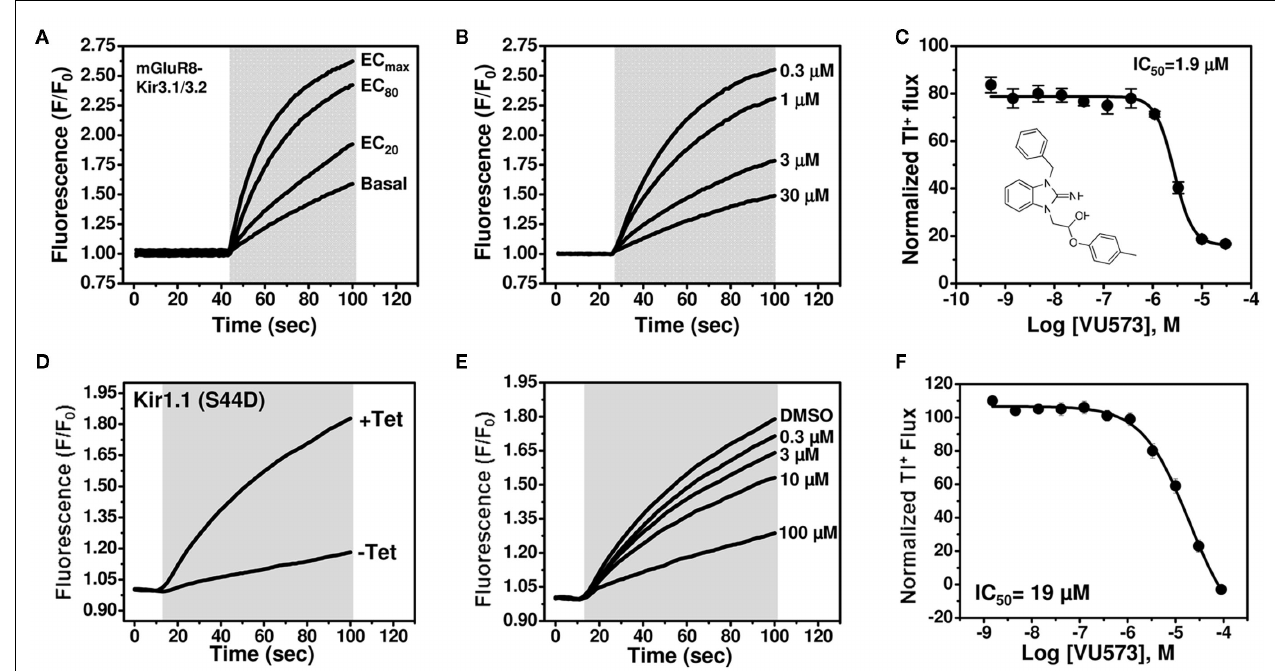
FIGURE 1 |VU573 inhibits mGluR8-activated Kir3.1/3.2 channel activity in thallium flux assays. (A) Representative FluoZin-2 fluorescence traces recorded from HEK-293 cells stably expressing mGluR8 and Kir3.1/3.2 before and after co-application of thallium and different doses of glutamate (shaded box). From an 11-point glutamate concentration–response curve (not shown), the glutamate concentration evoking approximately 80% (EC 80 ) of the maximal response (EC max ) was determined and used for subsequent experiments. (B) Representative traces for changes ofTl + -induced FluoZin-2 fluorescence following 20min pre-treatment of cells with the indicated concentrations ofVU573 and subsequent thallium and glutamate-EC 80